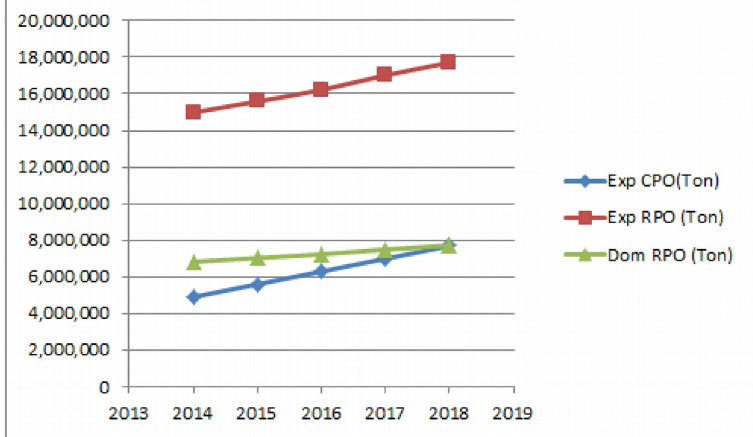
Figure 11. Model Solution: CPO Export, RPO export and domestic